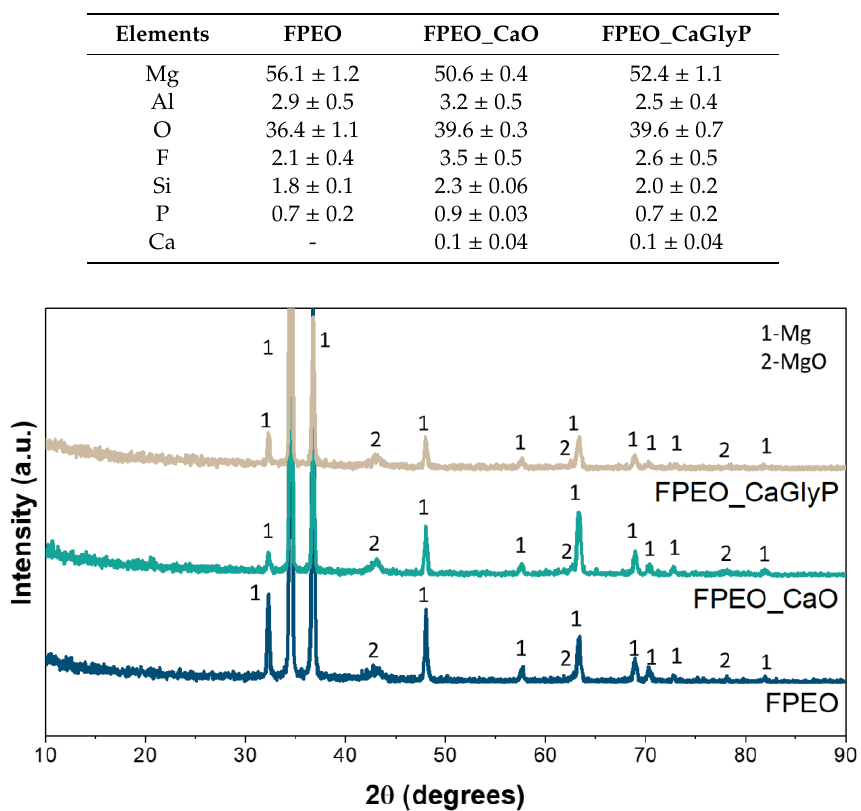
Table 4. Averaged results of the local EDS surface analysis of the coatings (at.%).